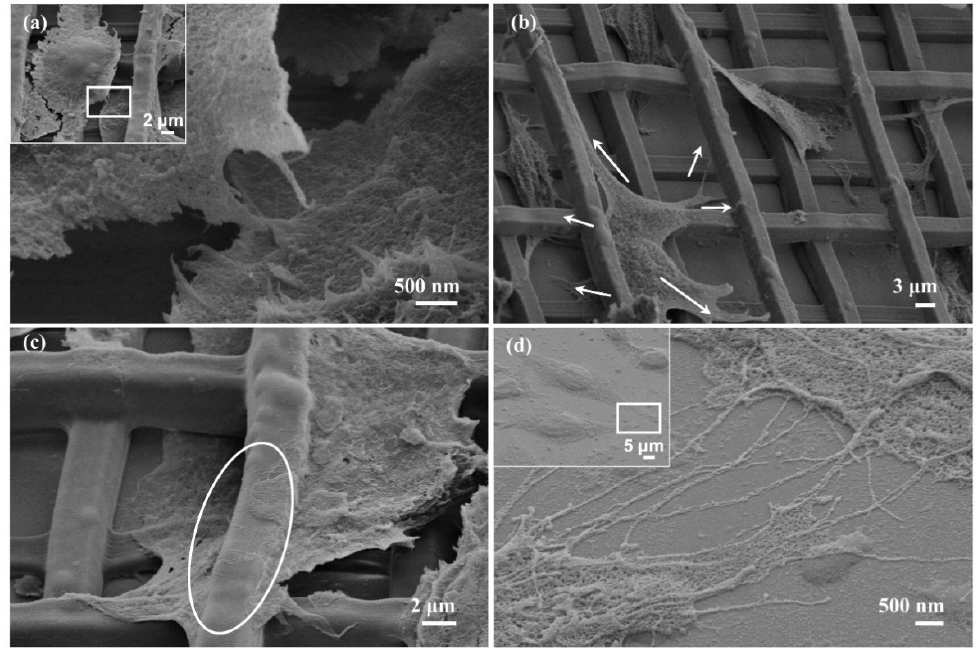
Figure 9. Cell–cell interactions in different forms. SEM images of the cell–cell interactions in ( a ) direct form, ( b ) long-distance remote form, and ( c ) strut-entangled form. ( d ) SEM images of the cell–cell interactions on the flat substrate.